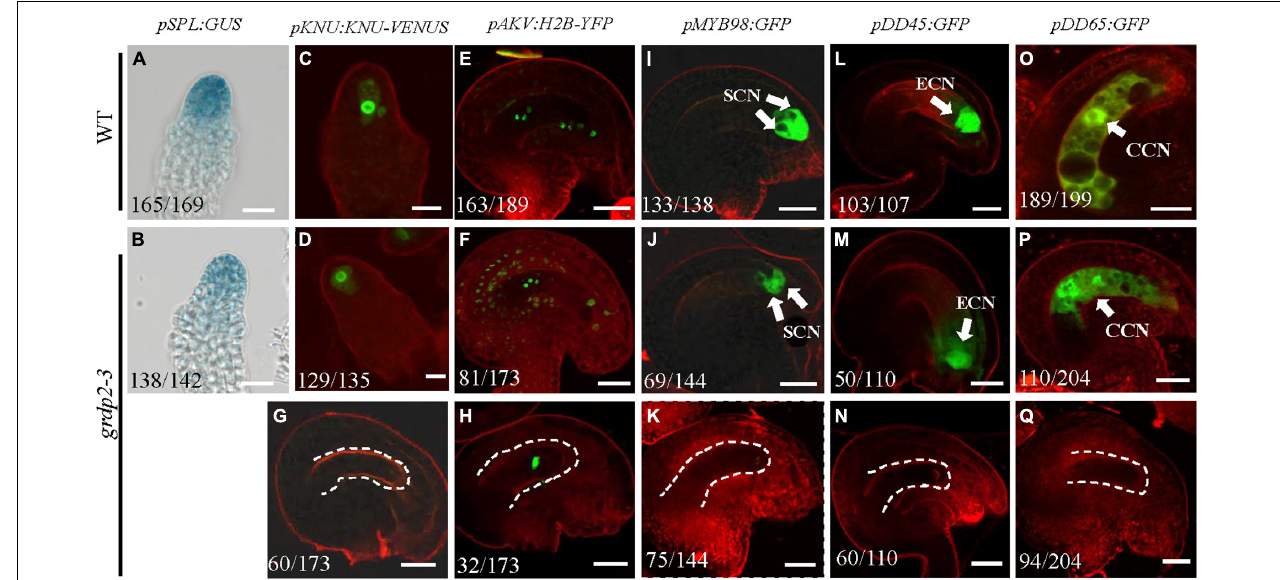
FIGURE 6 | Expression of female gametophyte specific markers. (A,B) pSPL:GUS expression in (A) WT at stage 2-I ovules prior to entering meiosis (165/169) and (B) grdp2-3 stage 2-I ovules (138/142). (C,D) pKNU:KNU-VENUS expression in (C) WT at MMC stage ovules (151/156) and (D) grdp2-3 at MMC stage ovules (129/135). (E) pAKV:H2B-YFP expression in WT at FG6/FG7 stage ovules (163/189), the rest ovules are in the FG5 stage. (F–H) pAKV:H2B-YFP expression in (F) grdp2-3 at FG6/FG7 stage ovules (81/173) ovules are same as the WT; (G) 60/173 ovules have no nucleus; and (H) 32/173 ovule have one nucleus. (I) pMYB98:GFP expression in WT at FG7 stage ovules (133/138). (J,K) pMYB98:GFP expression in grdp2-3 at FG7 stage ovules (J) 69/144 ovules are same as the WT and (K) 75/144 ovules have no GFP signal. (L) pDD45:GFP expression in WT at FG7 stage ovules (103/107). (M,N) pDD45:GFP expression in grdp2-3 at FG7 stage ovules (M) 50/110 ovules are same as the WT and (N) 60/110 ovules have no GFP signal. (O) pDD65:GFP expression in WT at FG7 stage ovules (189/199). (P,Q) pDD65:GFP expression in grdp2-3 at FG7 stage ovules (P) 110/204 ovules are same as the WT and (Q) 96/204 ovules have no GFP signal. Bar = 25 µ m. CCN, central cell nuclei; ECN, egg cell nuclei; SCN, synergid cell nuclei; white arrows mean nuclei; white dotted lines mean embryo